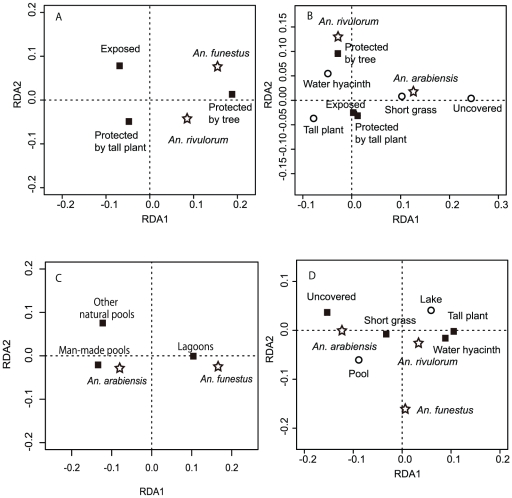
Redundancy analyses results showing the relationship between the vector species and the environmental factors for each habitat type: (A) hyacinth habitats, (B) lake habitats, (C) adjacent habitats, and (D) lake and adjacent habitats.Only the significant explanatory variables are included in the plots. The first axis was significant in the biplot for all cases, but the second axis was not significant in the analysis with water hyacinths.